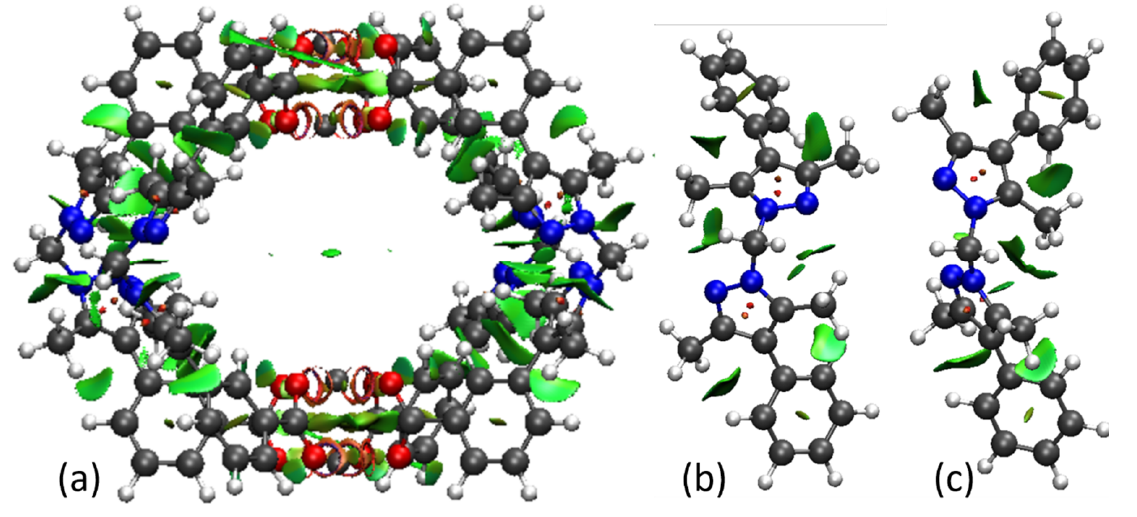
Figure 2. NCI plots of ( a ) MOC and the truncated ( b ) anti -O and ( c ) syn -O bis(pyrazolyl)methane sites. The isosurface represents a value of 0.5 with a color scale for the reduced density gradient (green is attractive while red is repulsive).